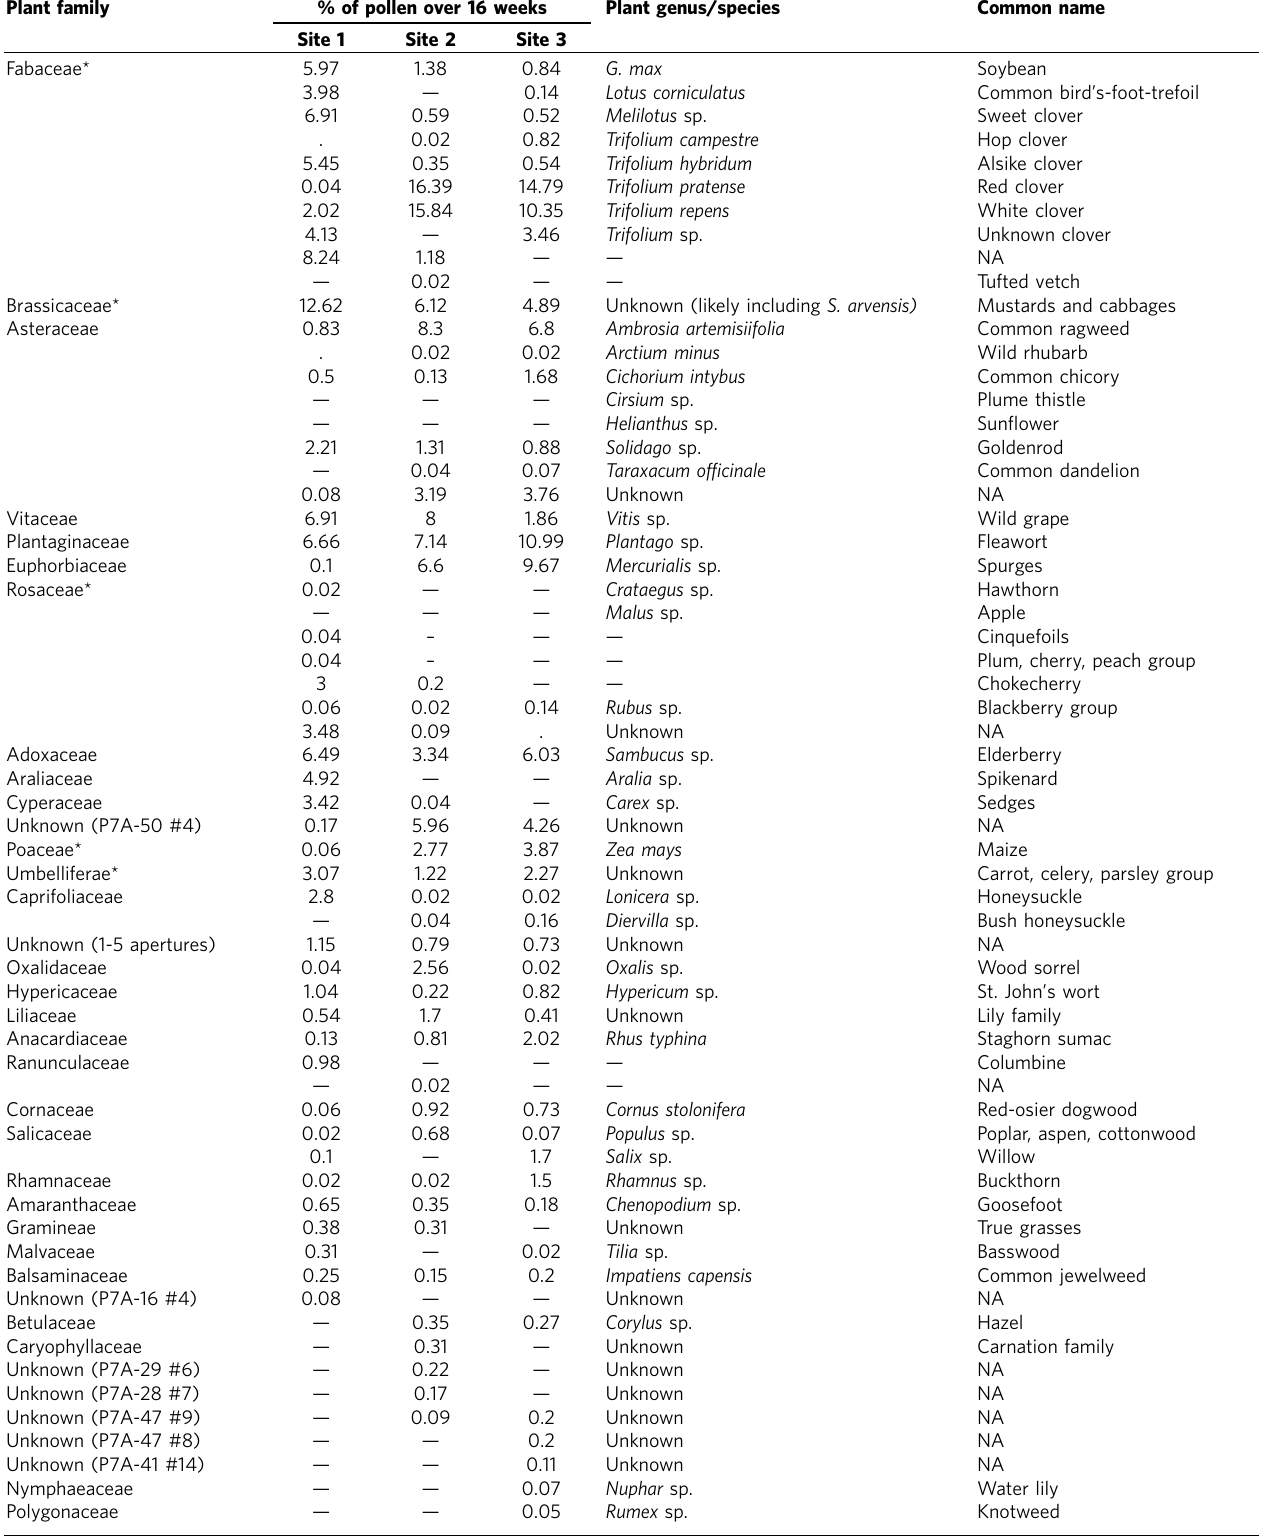
Honey bee hiveswere placedat one of threesites:(1)in a non-agriculturalarea( n ¼ 28plant families),(2) adjacenttoa maizefieldgrownfromuntreated seeds ( n ¼ 30plant families)or(3) adjacentto a maizefield grown frompesticide-treated seeds ( n ¼ 29plant families).Note: Asterisks denoteplant families that do or mayincludecultivatedplant species.Dashesdenotethat pollen froma particular plant family was not observed in honey bee pollen